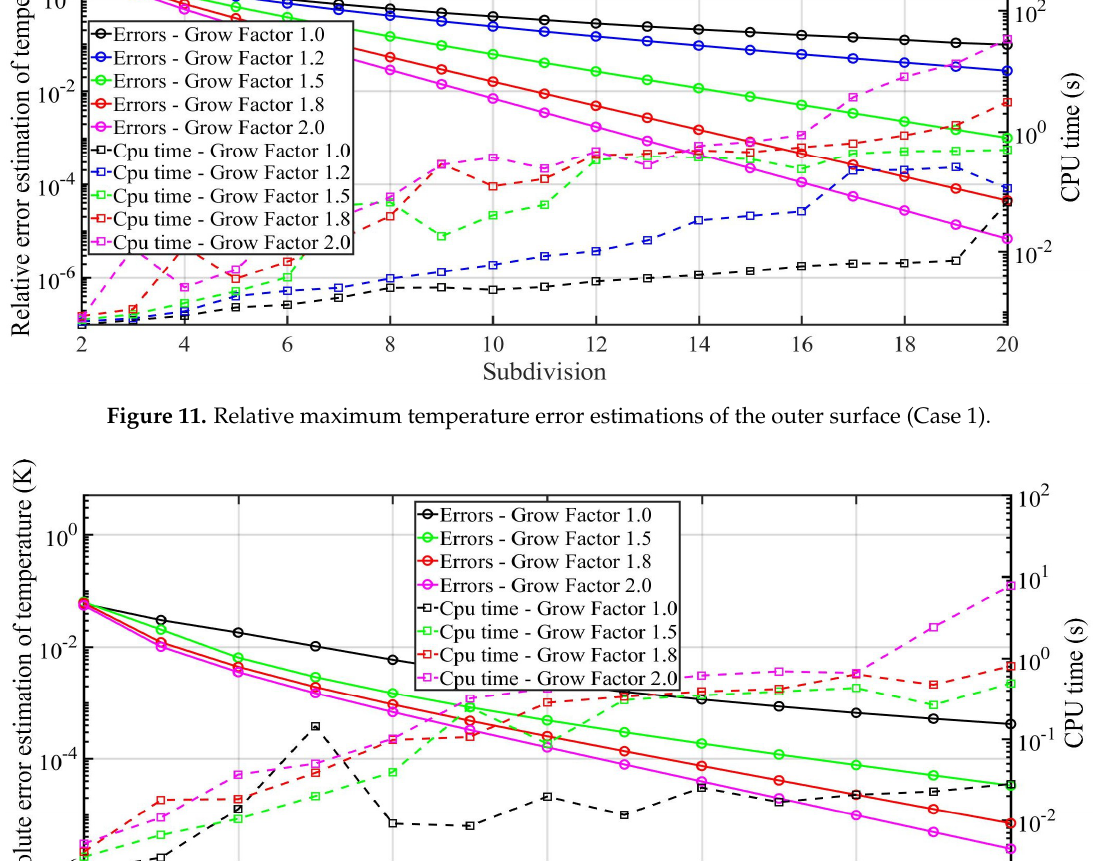
Figure 13. Absolute maximum temperature error estimations of the outer surface (Case 2). Figure 14. Relative maximum temperature error estimations of the inner surface (Case 2).